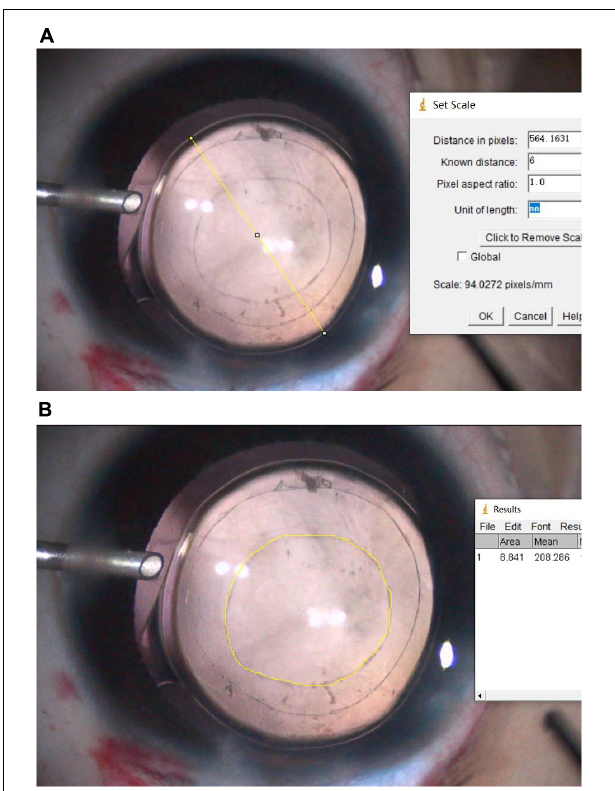
FIGURE 2 | (A) : The optic diameter of the intraocular lens (IOL) was marked (yellow line), and the distance (pixelated yellow line) was measured. The original image magnification scale was obtained through the distance in pixels/known distance (the optic diameter of the IOL). (B) : The contour of the posterior capsular opening area was marked using a pointer. The original area (mm 2 ) was then calculated using the scale included in the Image J software.